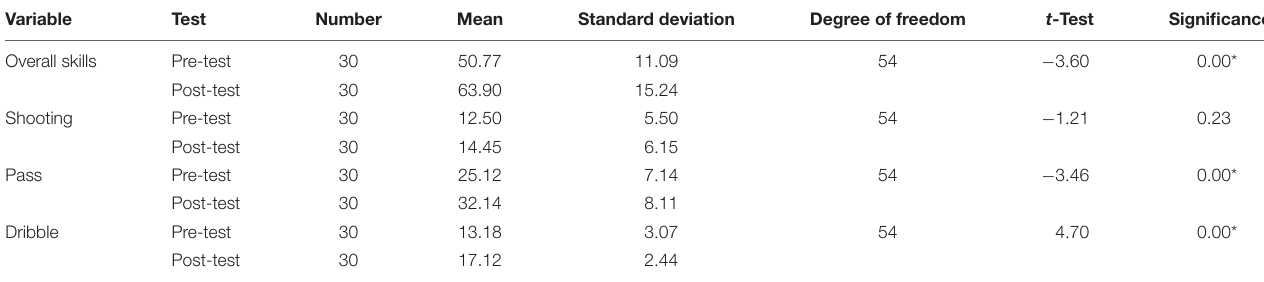
TABLE 7 | t -test analysis of the basketball skill performance pre-test and post-test repeated measures of the control group.